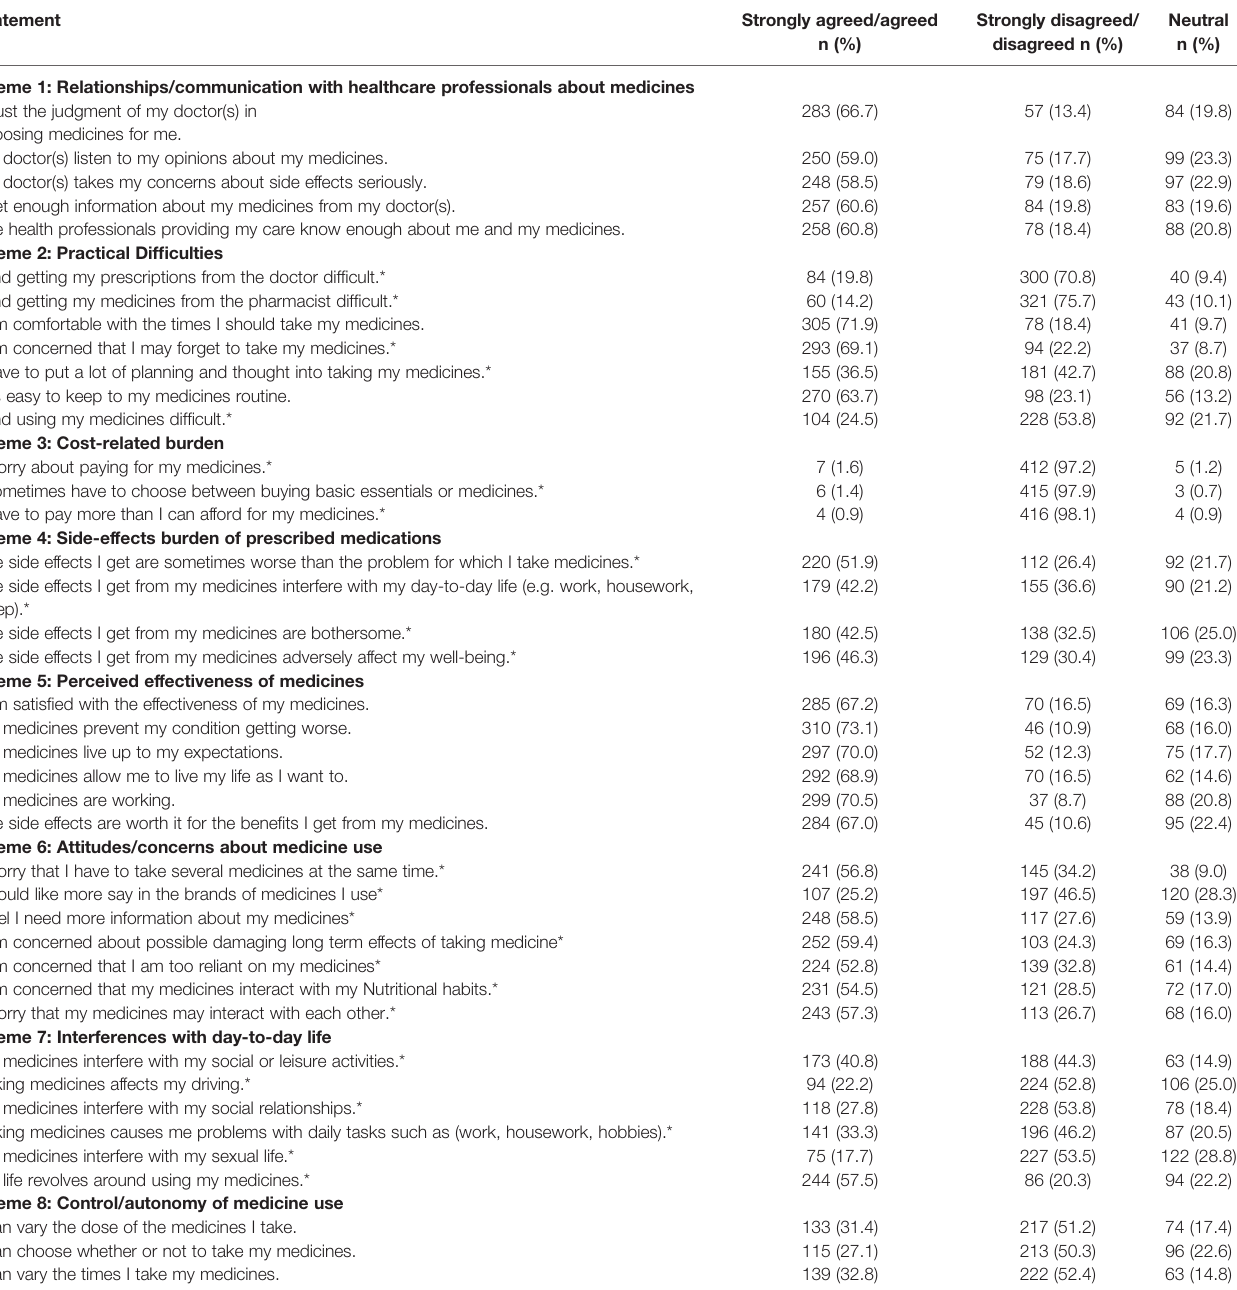
TABLE 2 | Responses to individual items in the eight domains of the Living with Medicines Questionnaire version-3 (LMQ ‐ 3)